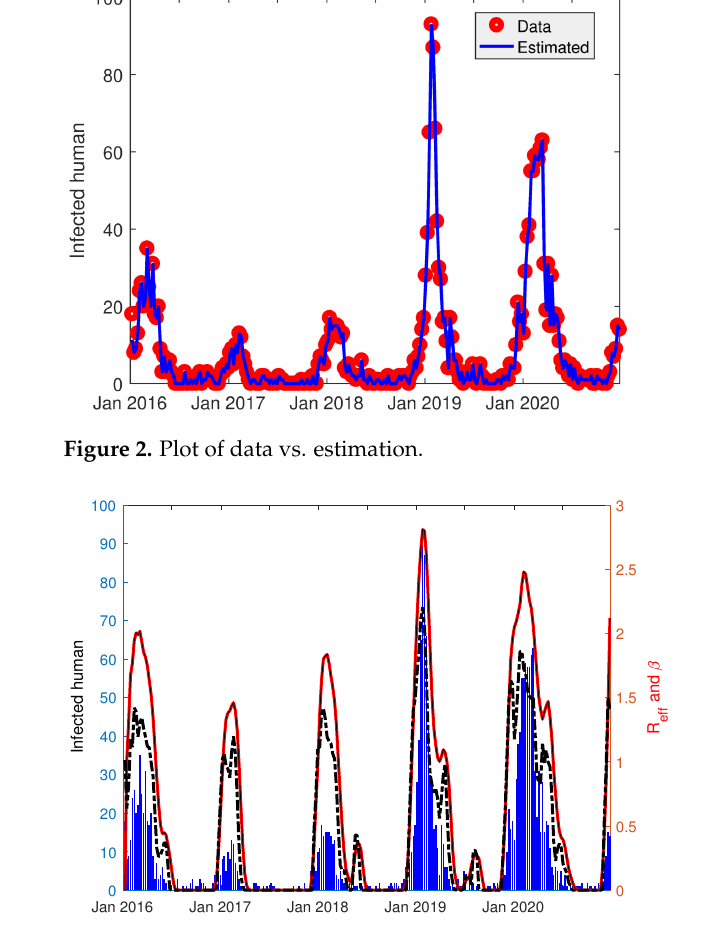
Figure 3. Plot of data reproduction number and transmission rate. The blue is the data, the solid red line is the reproduction number and dashed black line is the transmission rate over